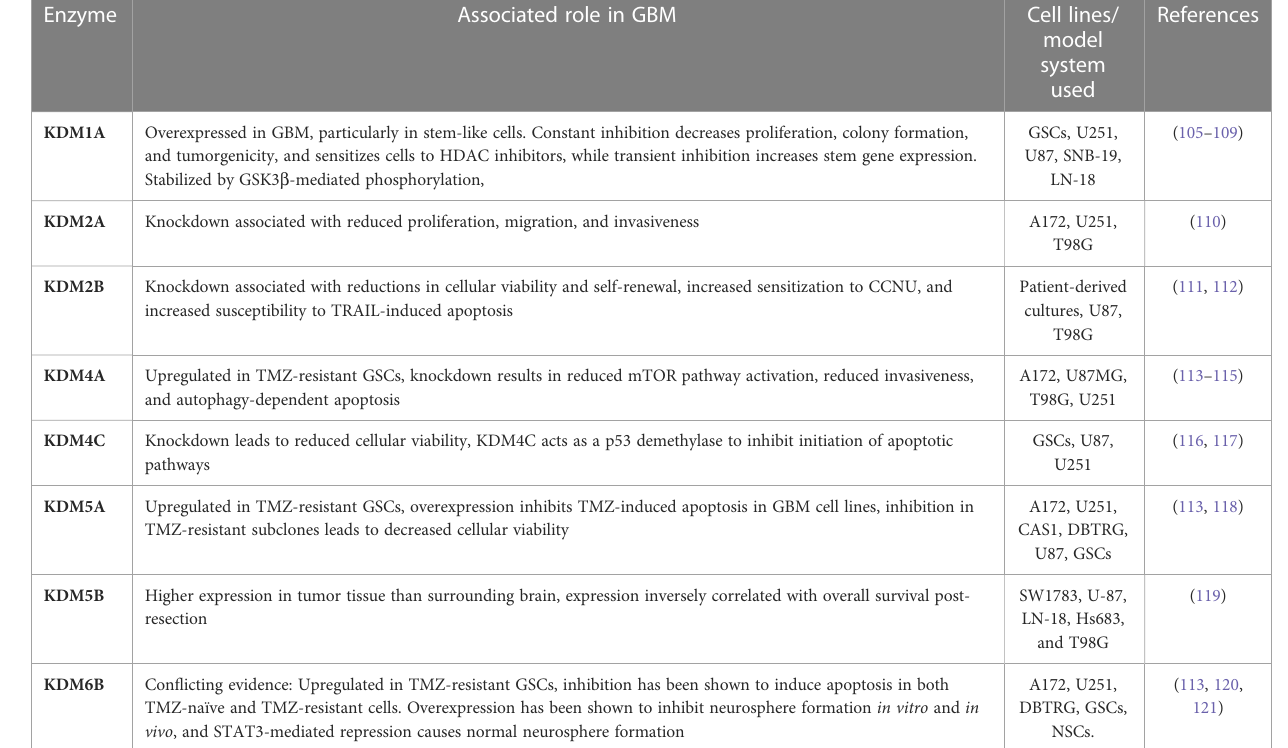
TABLE 3 The function of histone demethylases in